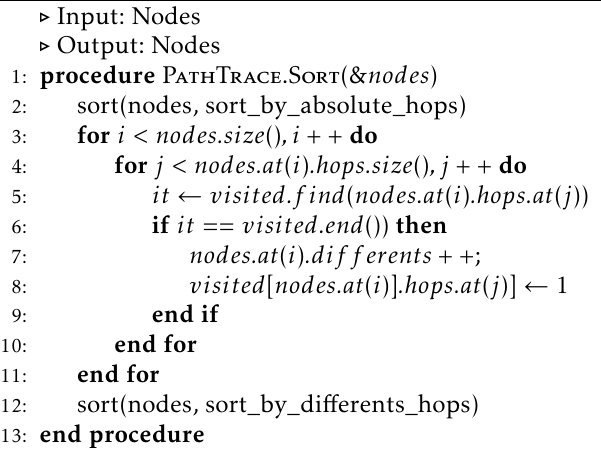
Algorithm 1 Sorting destination nodes on the gateway by greatest path impact, reaching the higher number of distinguished nodes